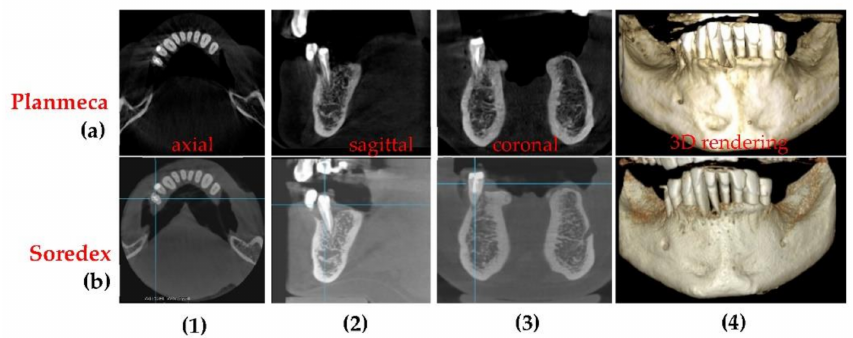
Figure 15. 3D CBCT performed on the same patient (B.R., female, 53 years old) with ( a ) the Planmeca unit and with ( b ) the Soredex unit. Notations: ( 1 ) axial, ( 2 ) sagittal, ( 3 ) coronal, and ( 4 ) 3D rendering.